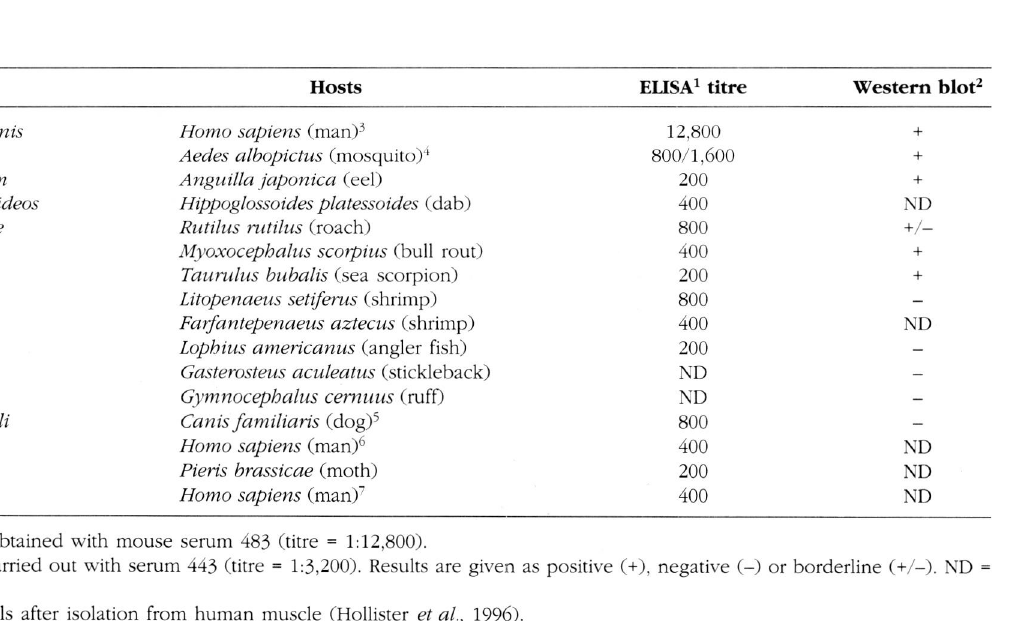
Table I. - Microsporidia and their hosts used in ELISA and Western